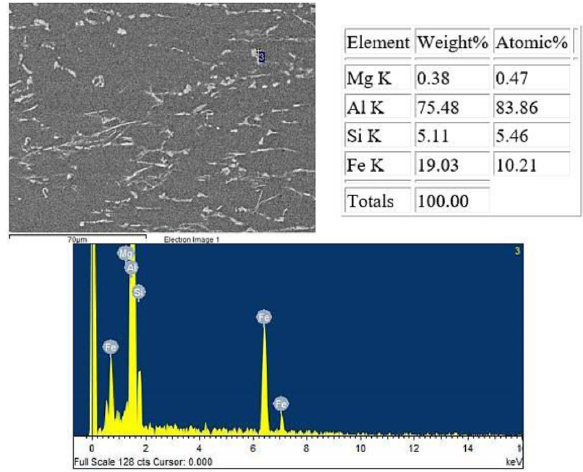
Figure 4: Point scan SEM-EDS analysis of boundary area of Al 6063/6 wt.% steel p composite.